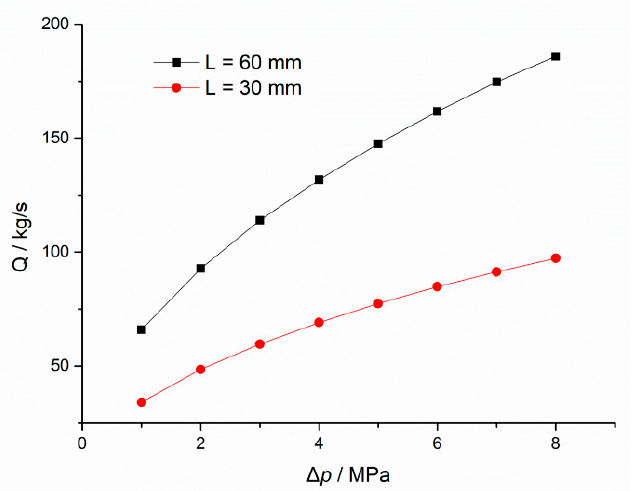
Figure 10. Flow rate variation with the increase of pressure difference for different openings.